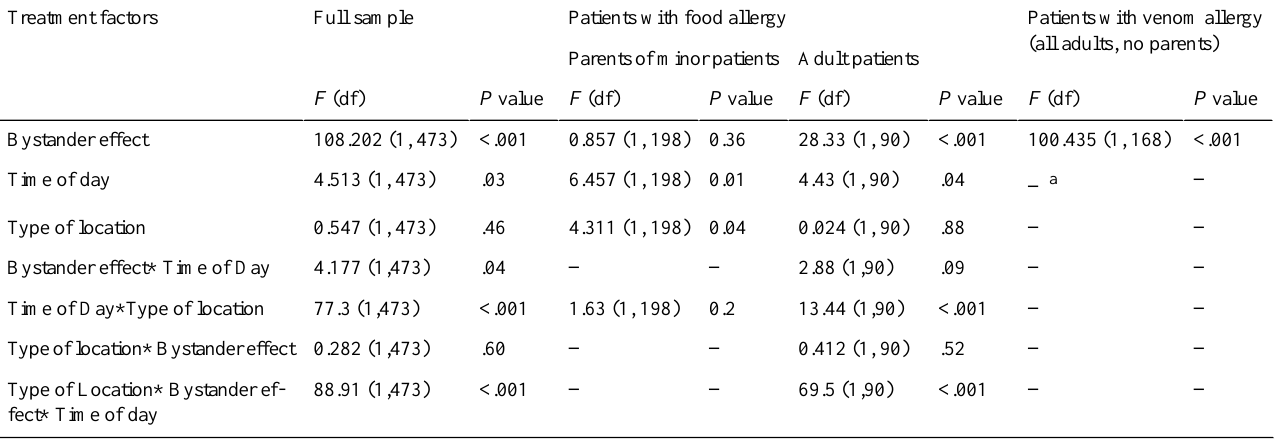
Table 6. Main effects and interactions of the three independent variables found by three-way analysis of variance test.